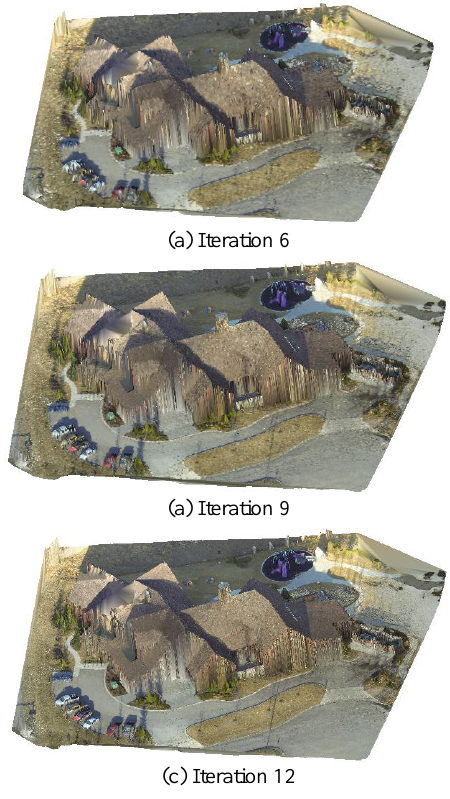
Figure 7. (a – c) Triangular mesh reconstruction from progressive dense